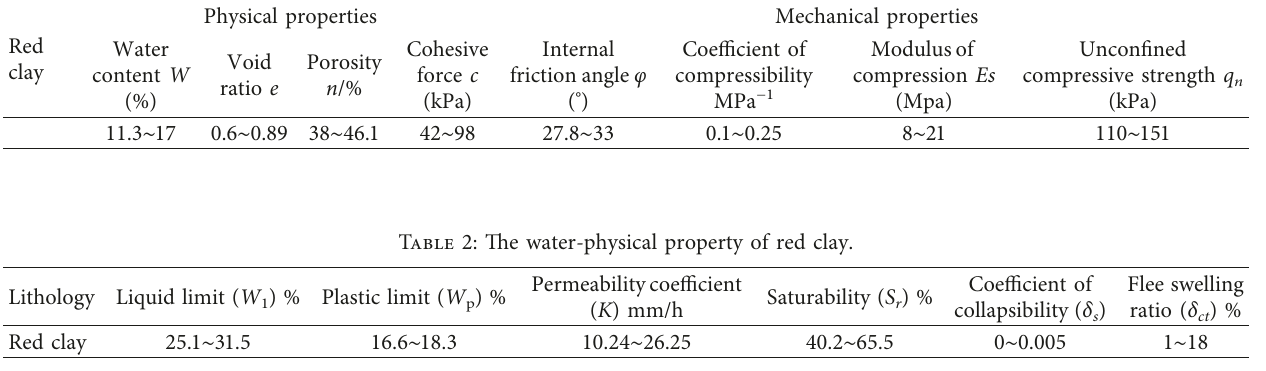
Table 1: Physical and mechanical properties of red clay.